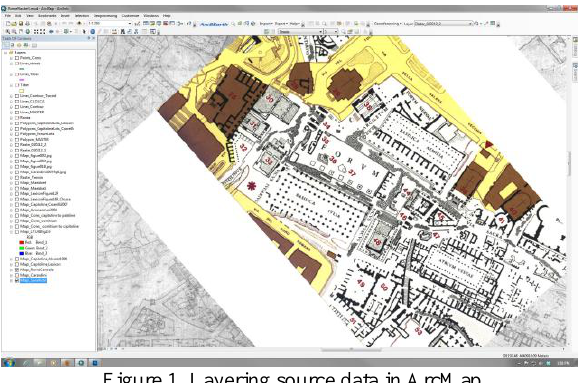
Figure 1. Layering source data in ArcMap